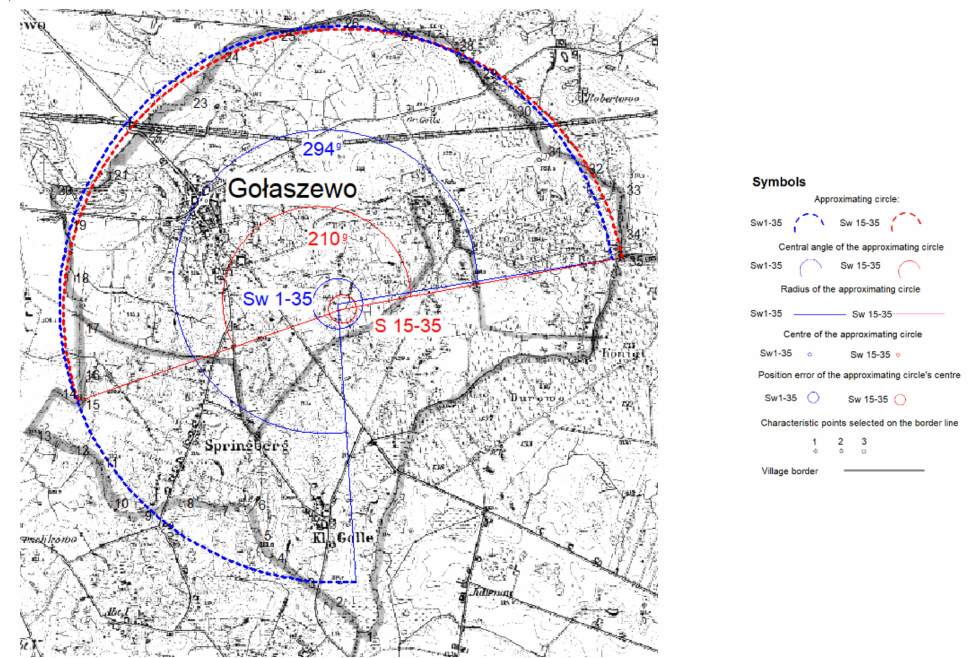
Figure 7. Gołaszewo. The course, position and error of the approximating circle: Sw 1—35— approximation of points 1—35, S 15—35—approximation of points 15—35. Scale